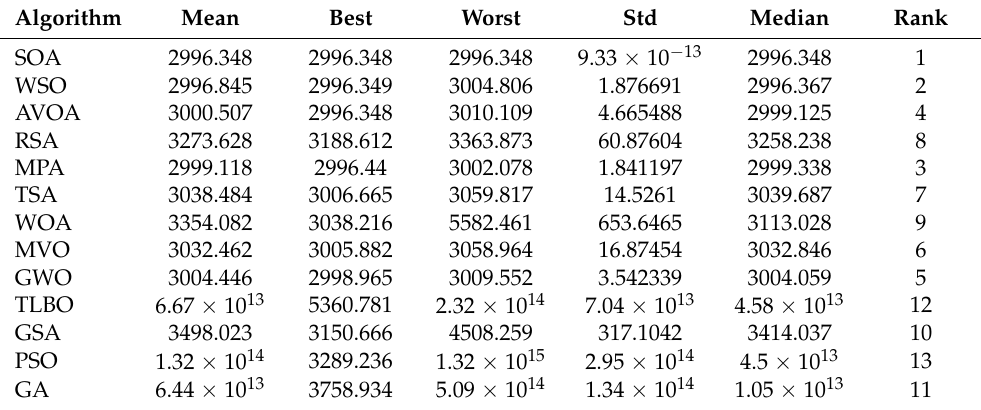
Table 12. Statistical results of optimization algorithms on the speed reducer design